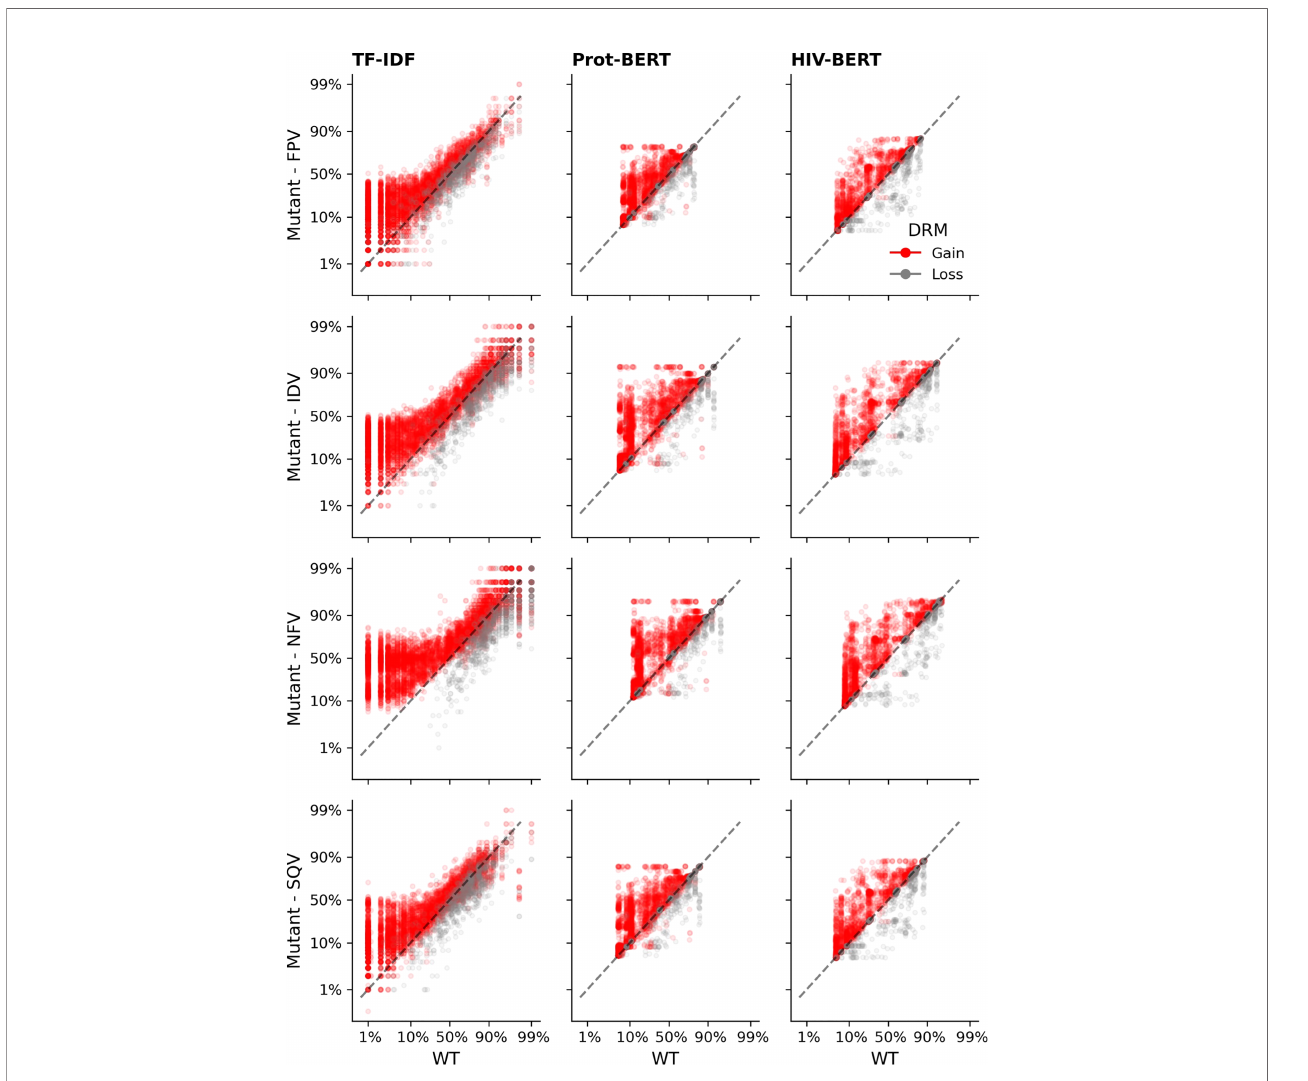
FIGURE 6 | Transformer models accurately predict the outcome of drug resistance mutations (DRMs). Each sequence in the resistance dataset was mutated by each of the ten DRMs as described in the methods and each mutated sequence is shown as a single point; there are ten points per sequence. Sequences where a DRM was added are shown in red which should increase the probability of resistance. Points in grey indicate sequences where a DRM was removed and should decrease in probability of resistance. The dashed black line shows the x=y line and the assumption of no change due to the mutation. Each column of axes shows the predictions using each of the three models. With the fi rst column indicating the TF-IDF model; the second indicating the Prot-BERT model; and the third showing the HIV-BERT results. Each row represents the prediction on a different drug in the order FPV, IDV, NFV, and